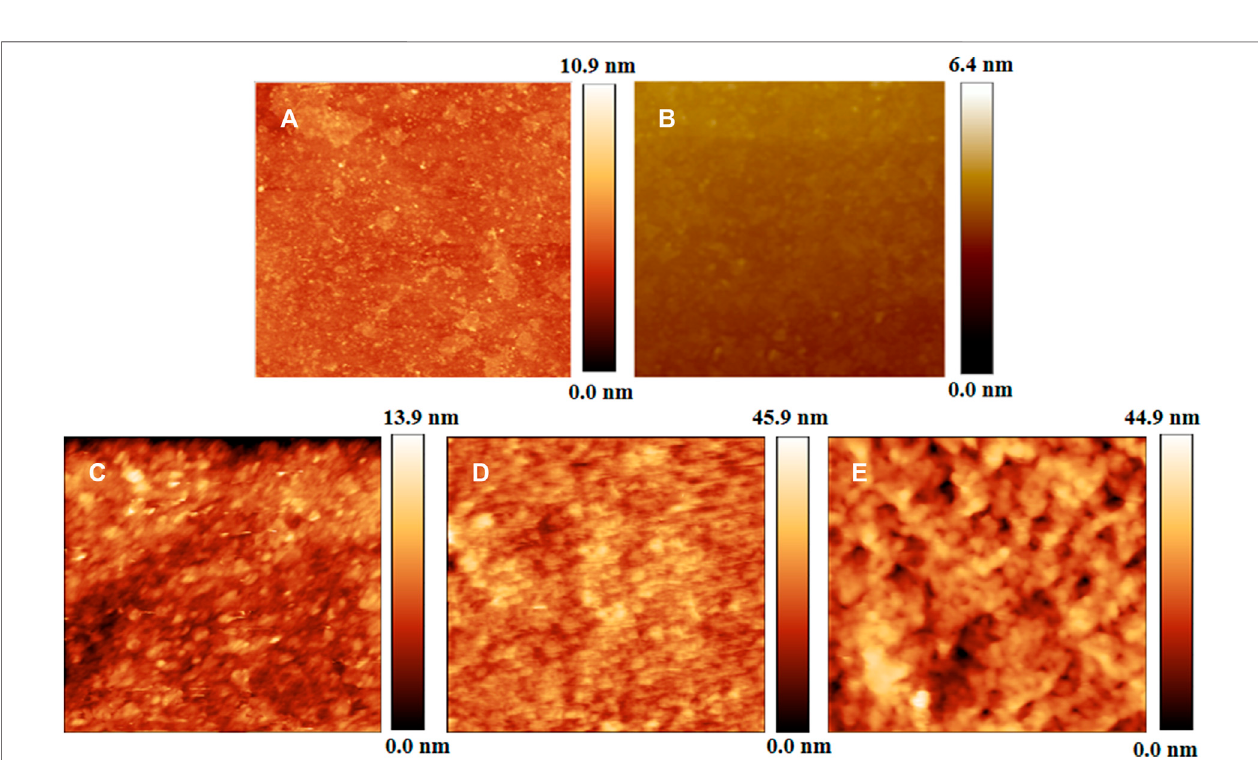
FIGURE 3 | Atomic force microscope (AFM) morphologies of GO self-assembled monolayer (SAM) (A) , PDDA SAM (B) , (GO/PDDA) 1 (C) , (GO/PDDA) 3 (D) , and